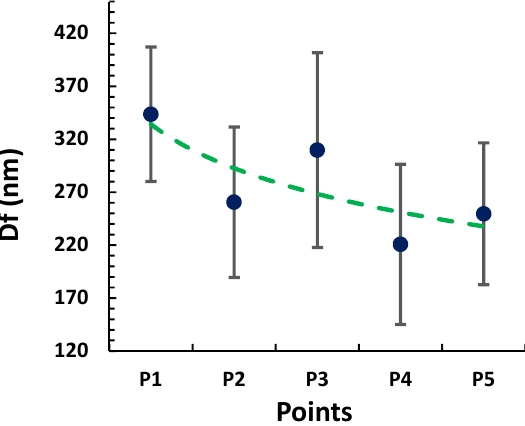
Figure 11. Evolution of the fiber diameter (Df) and its standard deviation as a function of the oper- ational points (P1, P2, P3, P4, and P5).